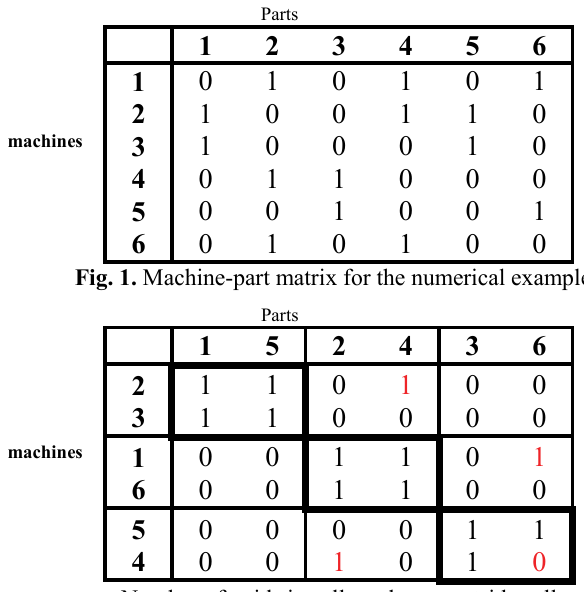
Fig. 2. Solution for Kusiak’s and Viswanathan’s approach